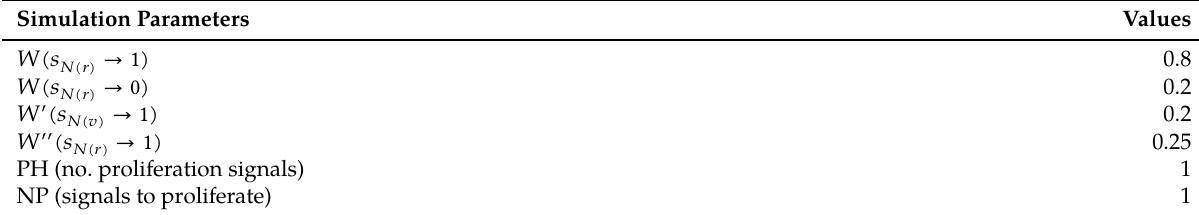
Table 1: Parameters of the tumor simulation model. Simulation Parameters